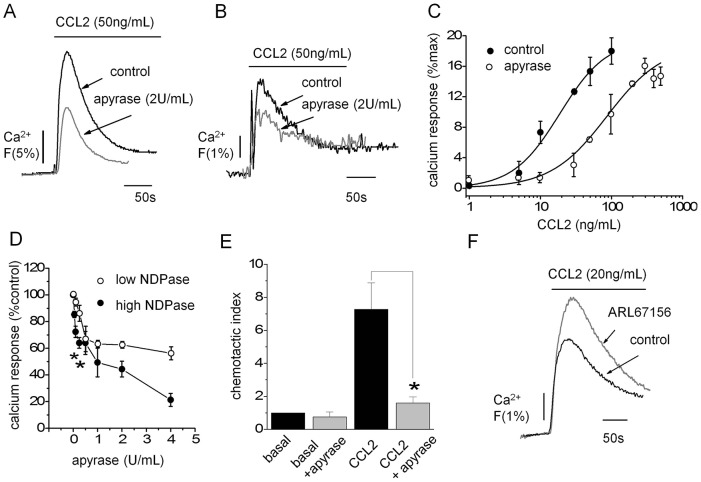
Effect of modulating extracellular nucleotides on THP-1 and human PBMC responses to CCL2. Representative traces showing effect of the nucleotide-scavenging enzyme apyrase on the CCL2-evoked Ca2+ signal in THP-1 cells (A) and human PBMCs (B). (C) Apyrase (2 U/ml) induced a rightwards parallel shift in the CCL2 concentration–response relationship for peak Ca2+ responses in THP-1 cells (n = 3). (D) Effect of apyrase enzymes with equal NTPase activity but high or low NDPase activity on peak Ca2+ responses evoked by CCL2 (50 ng/ml) expressed as a percentage of the response in the absence of enzyme (n = 3; *P<0.05, Students t-test). Enzyme units refers to NTPase activity. (E) Apyrase (2 U/ml) suppresses THP-1 chemotaxis towards CCL2 (50 ng/ml lower chamber, 2 h) in transwell migration assays (n = 5; *P<0.01, ANOVA). (F) Representative trace showing that the response to submaximal concentrations of CCL2 is potentiated following E-NTPDase inhibition (ARL67156, 100 µM; n = 9). Fluo-4 signals are normalised to maximum Ca2+ response elicited by 40 µM digitonin. Data are presented as mean±s.e.m. All antagonists were pre-incubated for 30 min prior to agonist challenge.